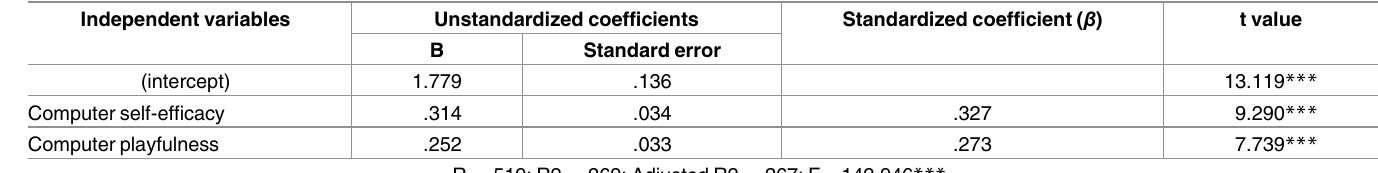
Table 5. Path analysis coefficient summaryof “computer self-efficacy” and “computer playfulness” to “perceived ease of use”.